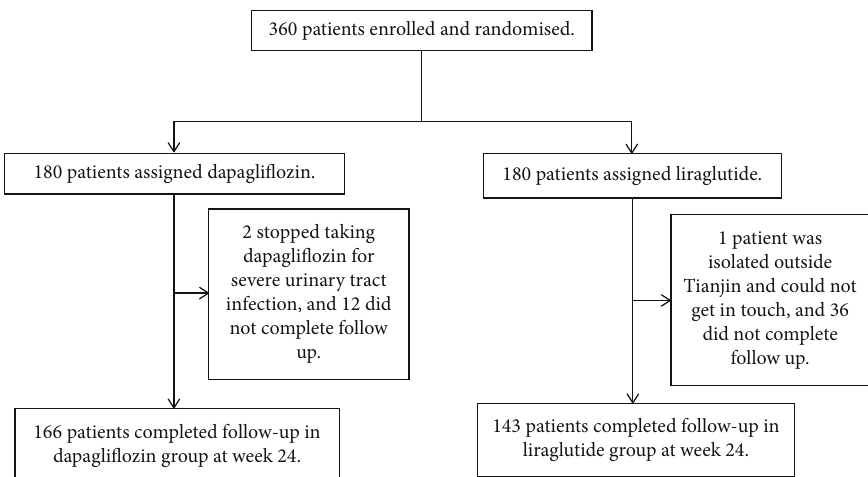
Figure 1: The study fl ow